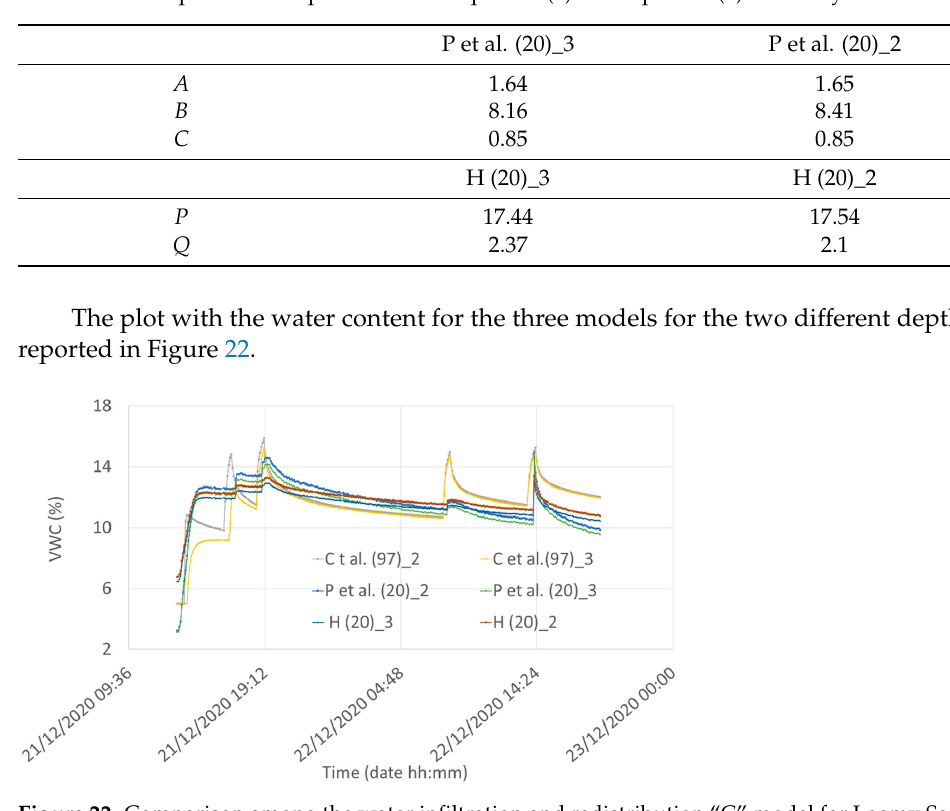
Figure 23. Statistical analysis with scattering plots, cross-correlation values, and kernel density estimation (KDE) in Loamy Sand. Figure 24 shows the comparison among the best results obtained from the correlation procedure. Even if a first sight comparison of the three curves shows significant differ- ences, it should be noted that for practical applications of sensors for measuring the soil water content, differences of a few percent are often irrelevant.